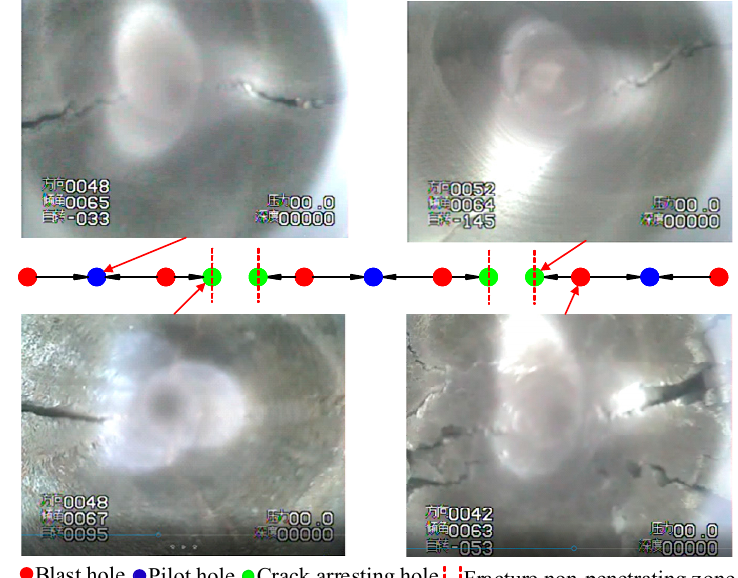
Figure 11. Borehole arrangement for non-penetrating fracture propagation control.